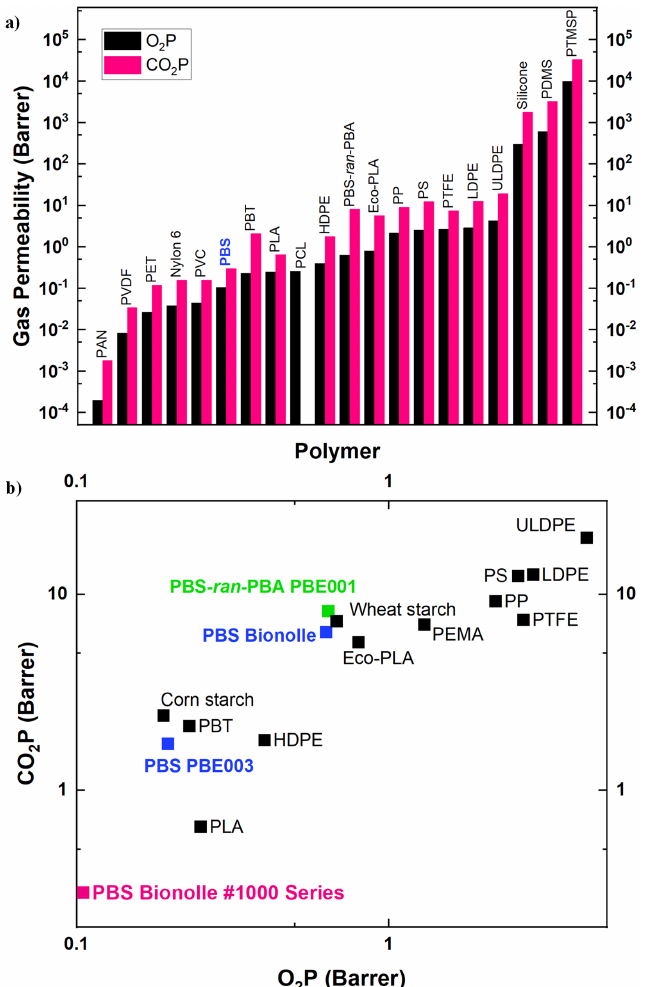
Figure 7. Gas barrier properties (O 2 P and CO 2 P) for several commercial polymers and biopolymers: ( a ) bar chart for a general overview and ( b ) plot for intermediate permeabilities (PBS region). Note that both axes are presented in decimal logarithm form. Data taken from [97,101,103,105,106,109,112–122].